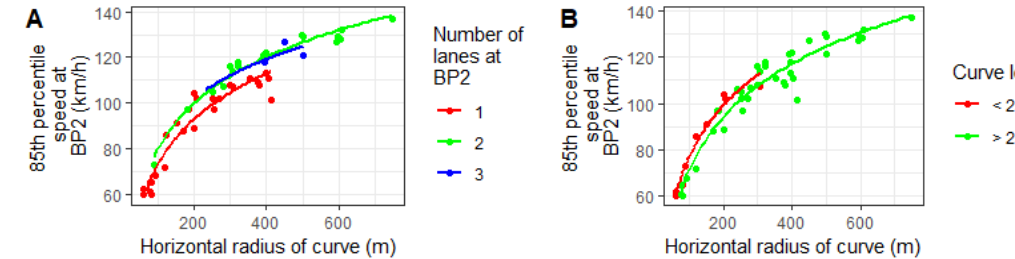
Figure 7. Sensitivity analysis on the number of lanes and length of a